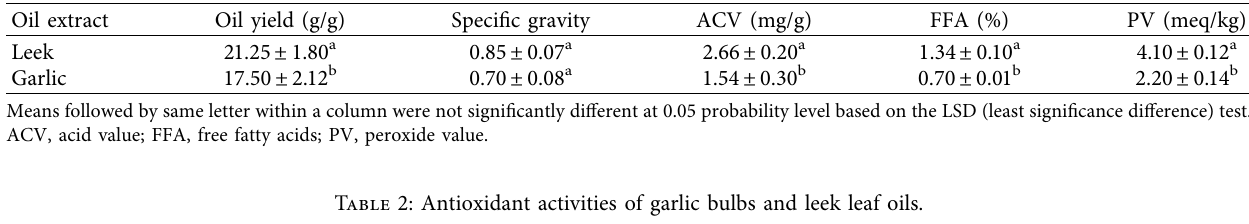
Table 1: Physicochemical properties of garlic bulb and leek leaf oils.